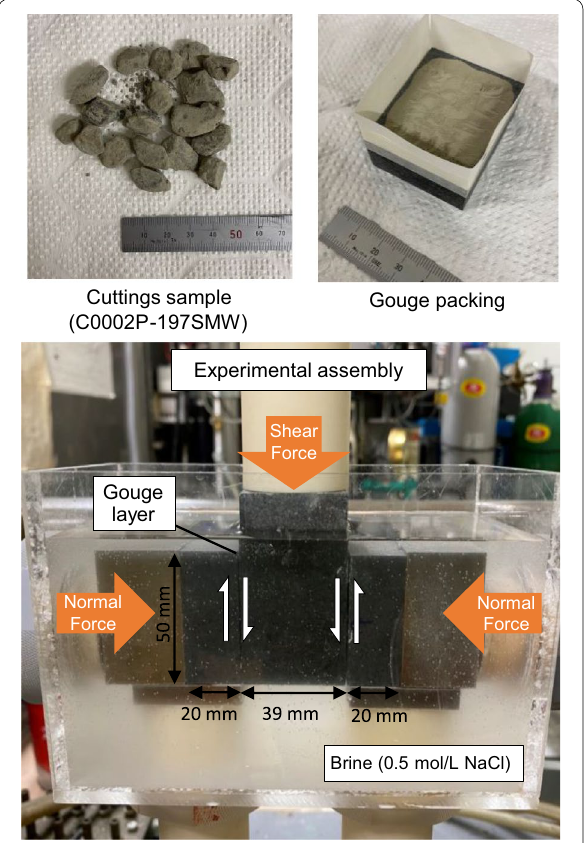
Fig. 3 Photographs of the cutting samples, preparation of the simulated gouges, and experimental apparatus. The experiments were conducted under fluid-saturated conditions using a 0.5 mol/L NaCl solution